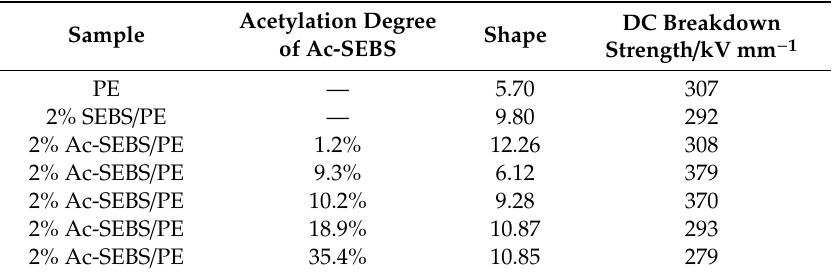
Table 2. DC characteristic breakdown strengths and shape parameters of different acetylation degrees.